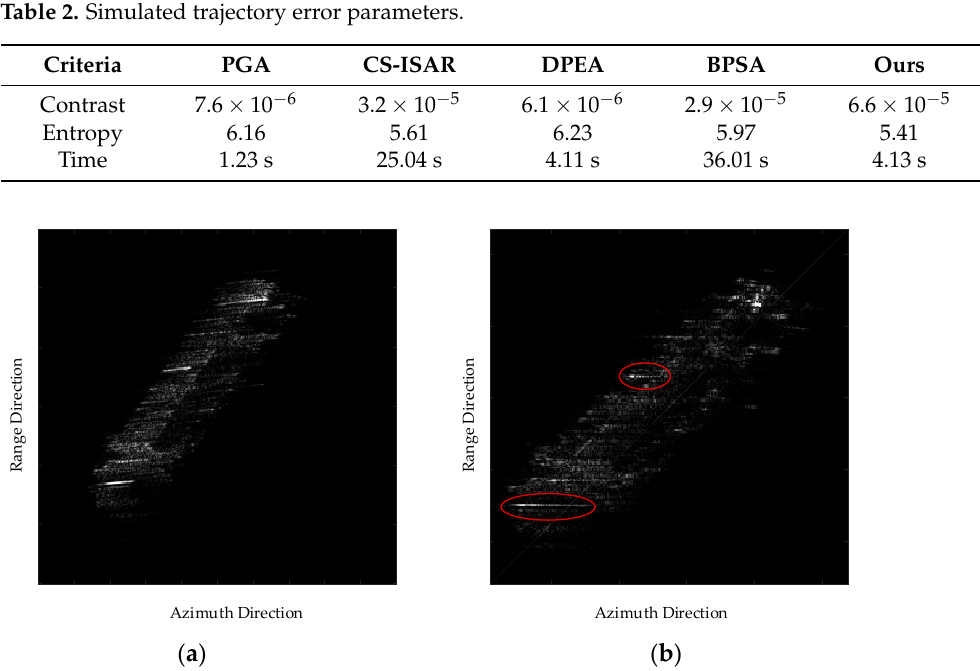
( f ) Figure 13. First case study results: ( a ) Rough imaging result of the tanker obtained by the BP integral; ( b ) Refocusing result obtained by the PGA algorithm; ( c ) Refocusing result obtained by the CS-ISAR algorithm; ( d ) Refocusing result obtained